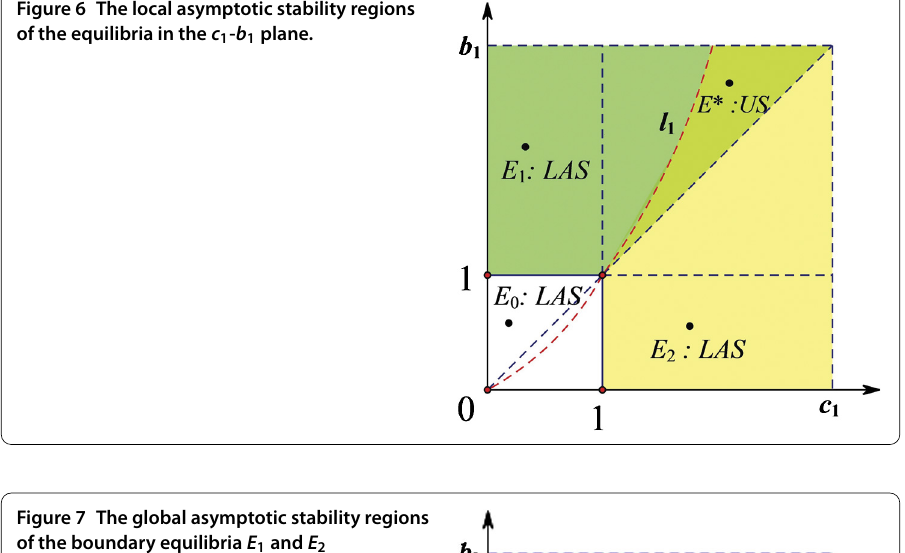
Figure 7 The global asymptotic stability regions of the boundary equilibria E 1 and E 2